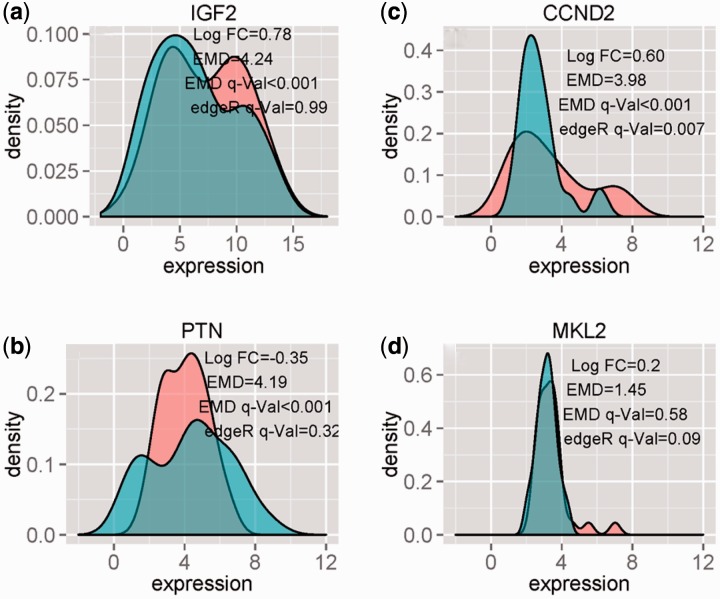
Density plots of IGF2, PTN, CCND2 and MKL2 for resistant (red) and sensitive (blue) samples using normalized read count data (TPM) from TCGA RNA-Seq data